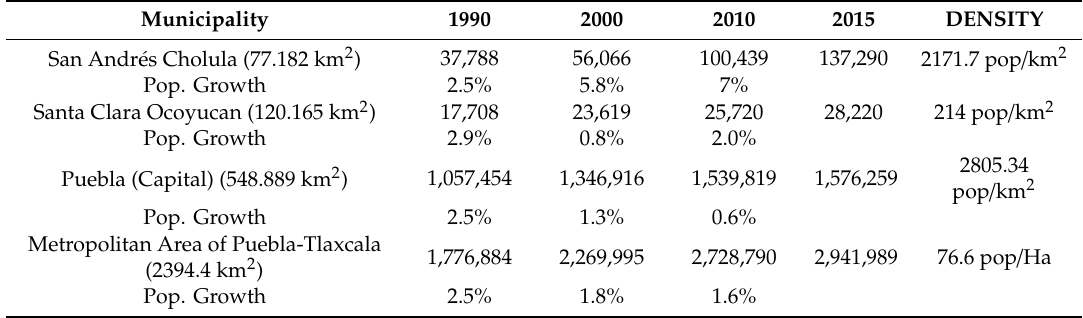
Table 2. Population Growth and density. Source: INEGI (2010, 2015), CONAPO (2018). Municipality 1990 2000 2010 2015 DENSITY San Andr é s Cholula (77.182 km 2 ) 37,788 56,066 100,439 137,290